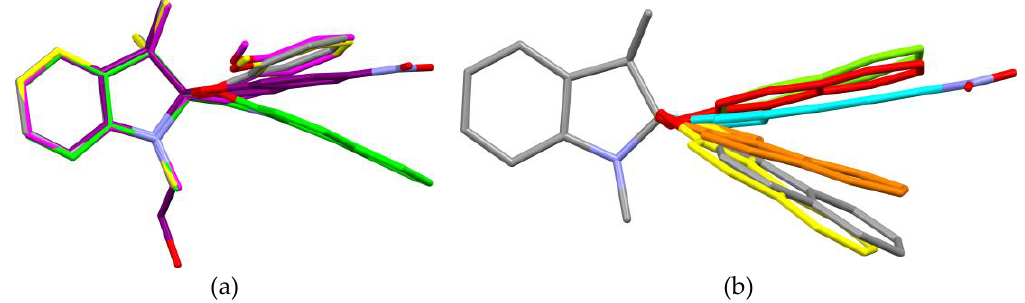
Figure 6. ( a ) Structure overlay of structure (I)–(IV) by superposing the indoline heterocycle, excluding C10. ( b ) Structure overlay of structural related entries in the CSD, showing the same type of superposition with focus on the chromene heterocycle.